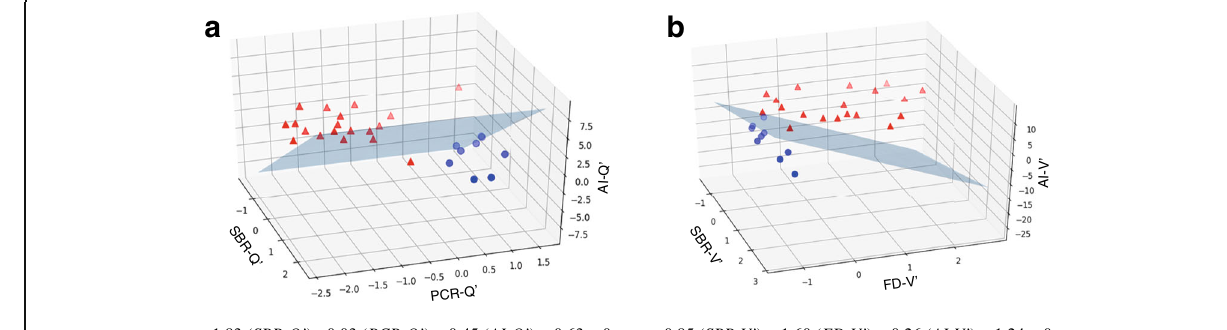
Fig. 4 Scatter plots of the PS (red triangles) and NPS (blue circles) cases. The blue planes are the boundary surfaces determined by the SVM classifier. The apostrophe represents the means after standardization. a The SVM-Q computed with SBR-Q, PCR-Q, and AI-Q. b The SVM-V computed with SBR-V, FD-V, and AI-V. Abbreviations: AI, asymmetry index; FD, fractal dimension; NPS, non-parkinsonian syndrome; PCR, putamen- to-caudate ratio; PS, parkinsonian syndrome; SBR, specific binding ratio; SVM, support vector machine